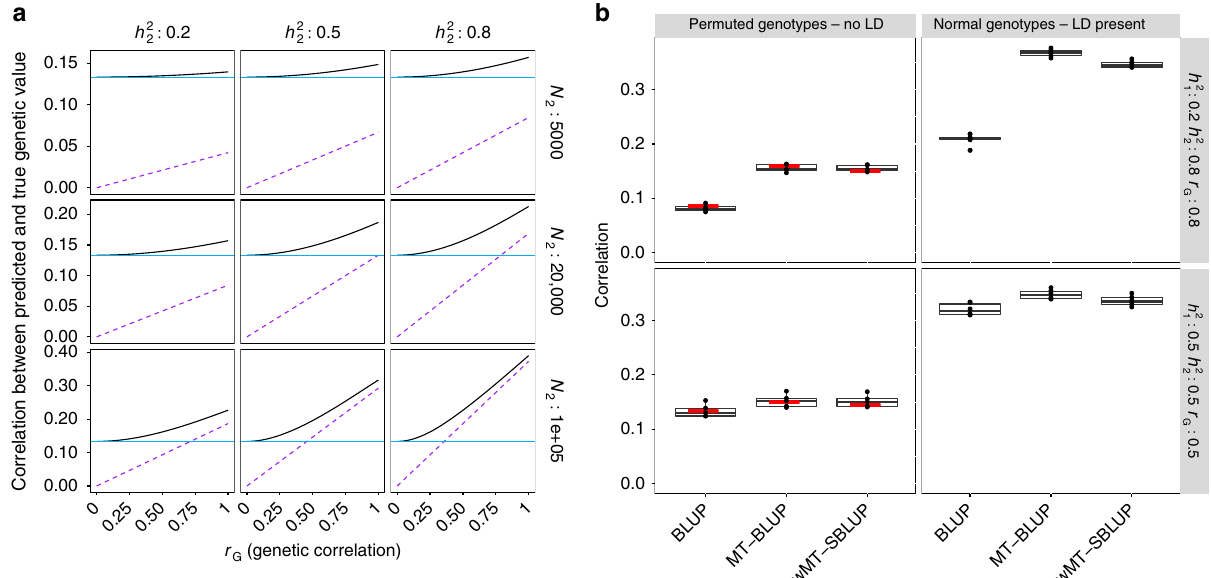
Fig. 2 Improving prediction accuracy using information from multiple traits. a Expected gain from multi-trait vs cross-trait predictors as a function of r G . Two traits are considered. The fi rst trait has a sample size of 20,000 and a SNP heritability of 0.5. The sample size and SNP heritability of the second trait vary between panels. The blue line shows the expected prediction accuracy of a single-trait predictor. The black line shows the expected prediction accuracy of a multi-trait predictor. The purple line shows the expected prediction accuracy of a cross-trait predictor (using only trait 2 to predict trait 1). The advantage of a multi-trait predictor over a cross-trait predictor decreases with increasing r G , h 2 , and sample size of the second trait. b Simulation results. Prediction accuracy is shown as correlation between simulated genetic value and predicted phenotype of individuals. Genotypes from European individuals in the GERA cohort were used for simulation. Boxplots show results across six replicates. In the left panels, the LD structure was removed by permuting dosage values for each SNP across all individuals. In the right panels, the original genotypes were used for simulation. Expected prediction accuracies were derived for the case of unlinked genotypes and are shown as red horizontal bars. In each section, the prediction accuracy of three predictors is shown: (1) single trait BLUP, (2) multi-trait BLUP (MT-BLUP), and (3) weighted approximate BLUP (summary statistic-based multi-trait predictor: wMT-SBLUP). Simulation in genotypes without LD results in prediction accuracies, which conform to expectations. In the presence of LD, the expected prediction accuracy depends very much on the choice of M